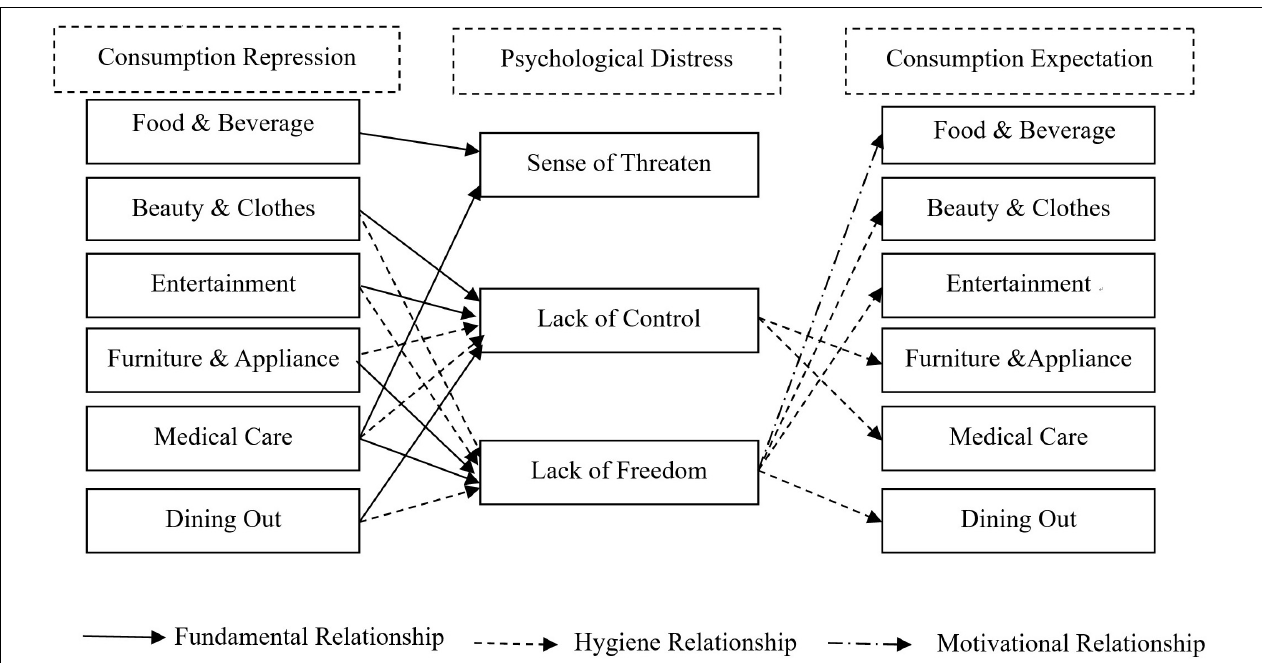
FIGURE 2 | The relationship between consumption repression, psychological distress and consumption expectation for different products.